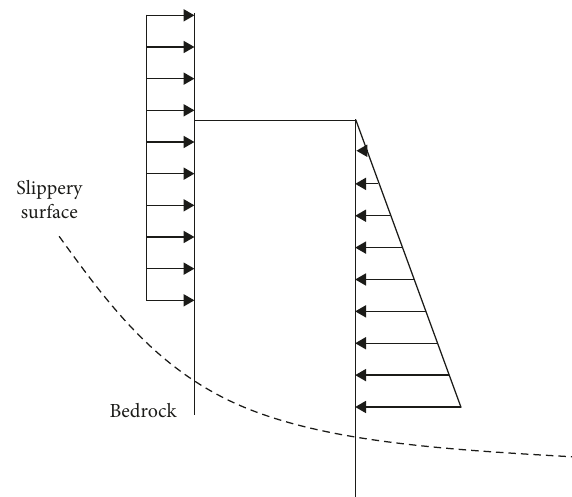
Figure 7: Theoretical calculation diagram of frame-type antislide